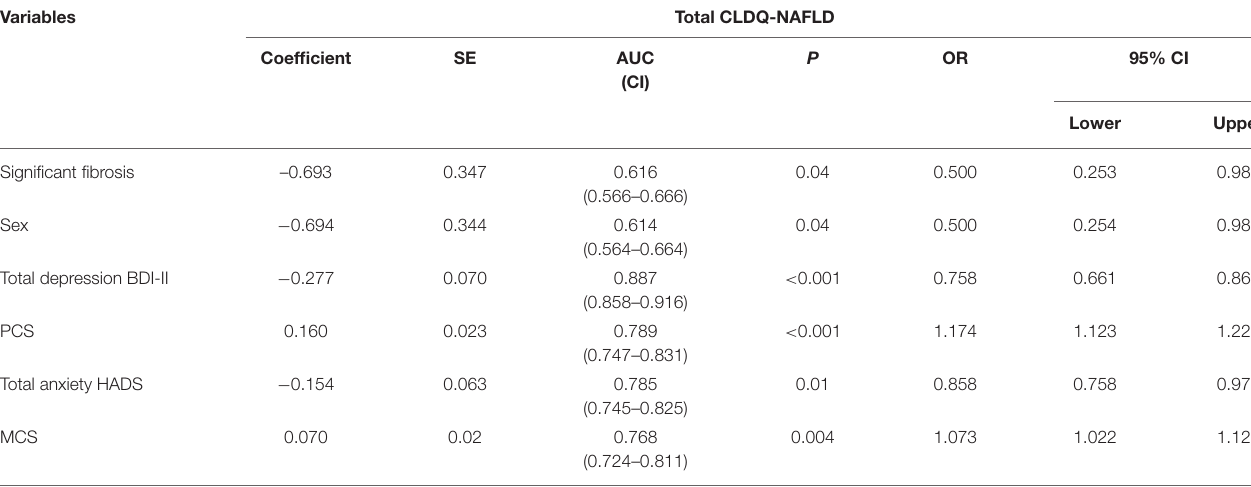
TABLE 11 | Binary logistic regression analysis with total CLDQ-NAFLD as the dependent variable.